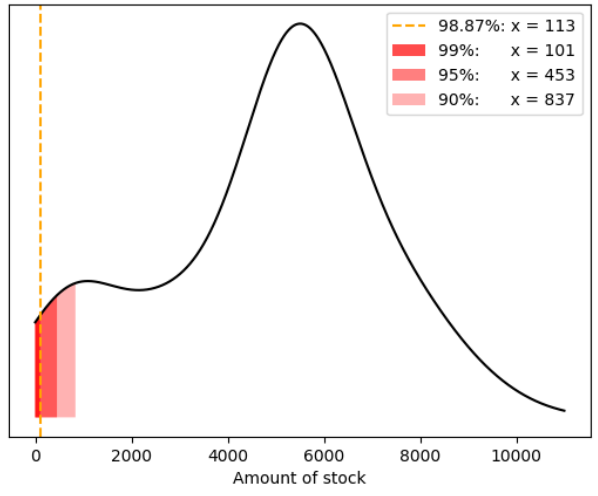
Figure 11. Probability distribution of order quantity (probability of more than 113 orders is more than 98.87% in